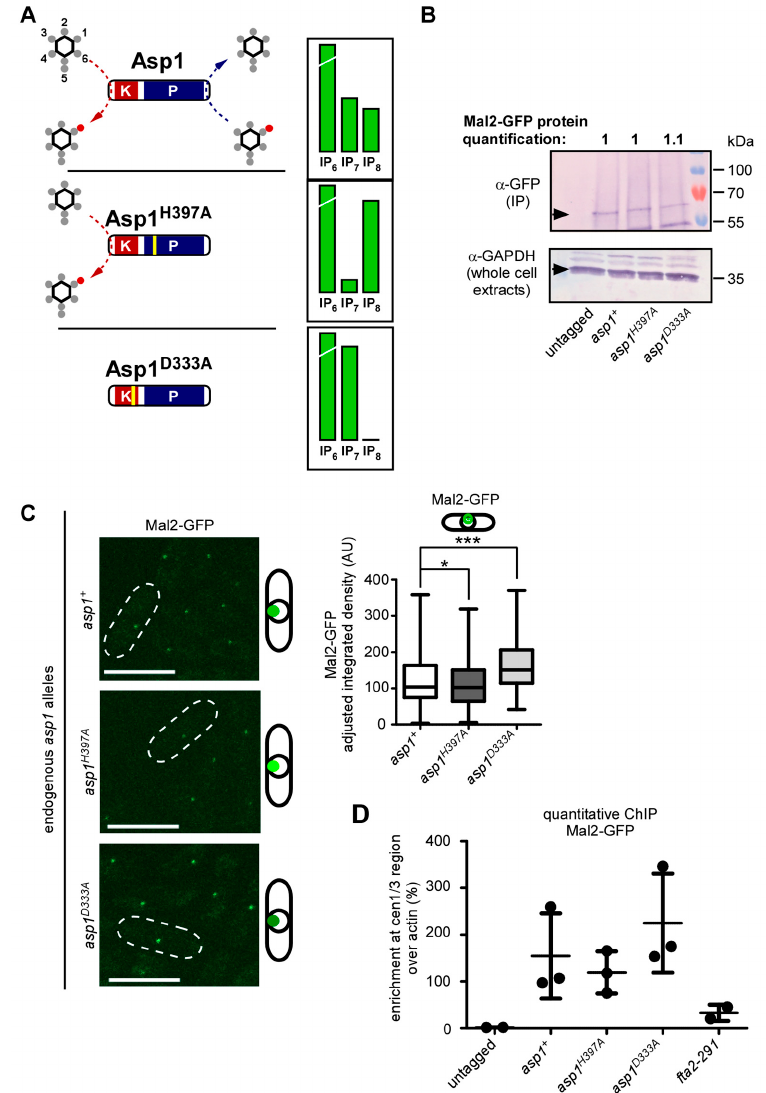
Figure 5. Kinetochore-targeting of wild-type Mal2 is subject to IP 8 levels . ( A ) Schematic represen- tation of the three endogenous Asp1 variants and their impact on IP 7 and IP 8 levels [36]. Note that in the case of Asp1 D333A , no IP 8 is generated and thus, no IP 8 is being hydrolyzed, although the pyrophosphatase domain is intact. ( B ) Western blot analysis of Mal2-GFP protein levels in specified asp1 -variant strains utilizing indicated antibodies. To detect Mal2-GFP, an immunopre- cipitation with anti-GFP antibodies was performed prior to Western blot analysis. Quantification of the fold change of Mal2-GFP bands that were normalized to GAPDH are shown above the blot. One of n = 2 sets shown. ( C ) Left: Live-cell images of the indicated asp1 -variant strains endogenously expressing mal2 + - gfp grown at 25 ◦ C. Scale bars, 10 µ m. Right: Quantification of the Mal2-GFP fluorescence signals in each strain. Mean and SD: asp1 + = 122.5 AU ± 63.67; asp1 H397A = 110.8 AU ± 58.43; asp1 D333A = 163.8 AU ± 65.53. The number of kinetochore signals that were counted, asp1 + n = 381; asp1 H397A n = 381; asp1 D333A n = 380. *, p = 0.0195; ***, p < 0.0001; Mann–Whitney U-Test. Average of n = 3 shown. ( D ) qChIP analysis for the strains that were im- aged in ( C ). Shown is the enrichment of cen1/3 DNA relative to the act1 + locus. The mean and SD shown: untagged (wild-type strain) = 1.99 ± 0.32; asp1 + = 154.67 ± 90.99; asp1 H397A = 119.55 ± 45.01; asp1 D333A = 224.83 ± 105.56; fta2-291 = 33.03 ± 17.06. Untagged and fta2-291 strains, n = 2. asp1 + , asp1 D333A , asp1 H397A strains n = 3 biological replicates with 2-4 technical replicates